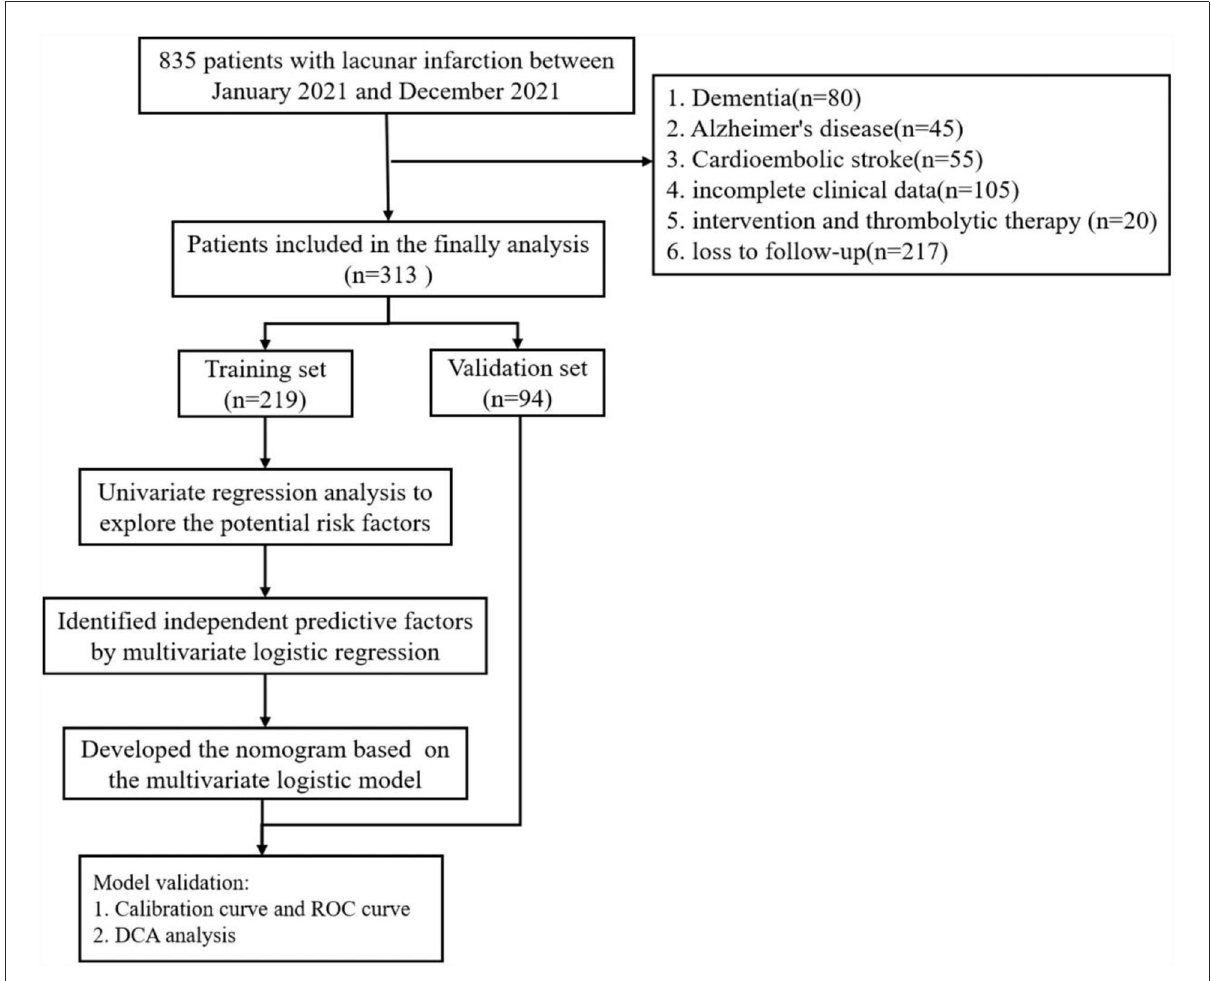
FIGURE1 Schematic of patient’s inclusion process and flowchart with the study.